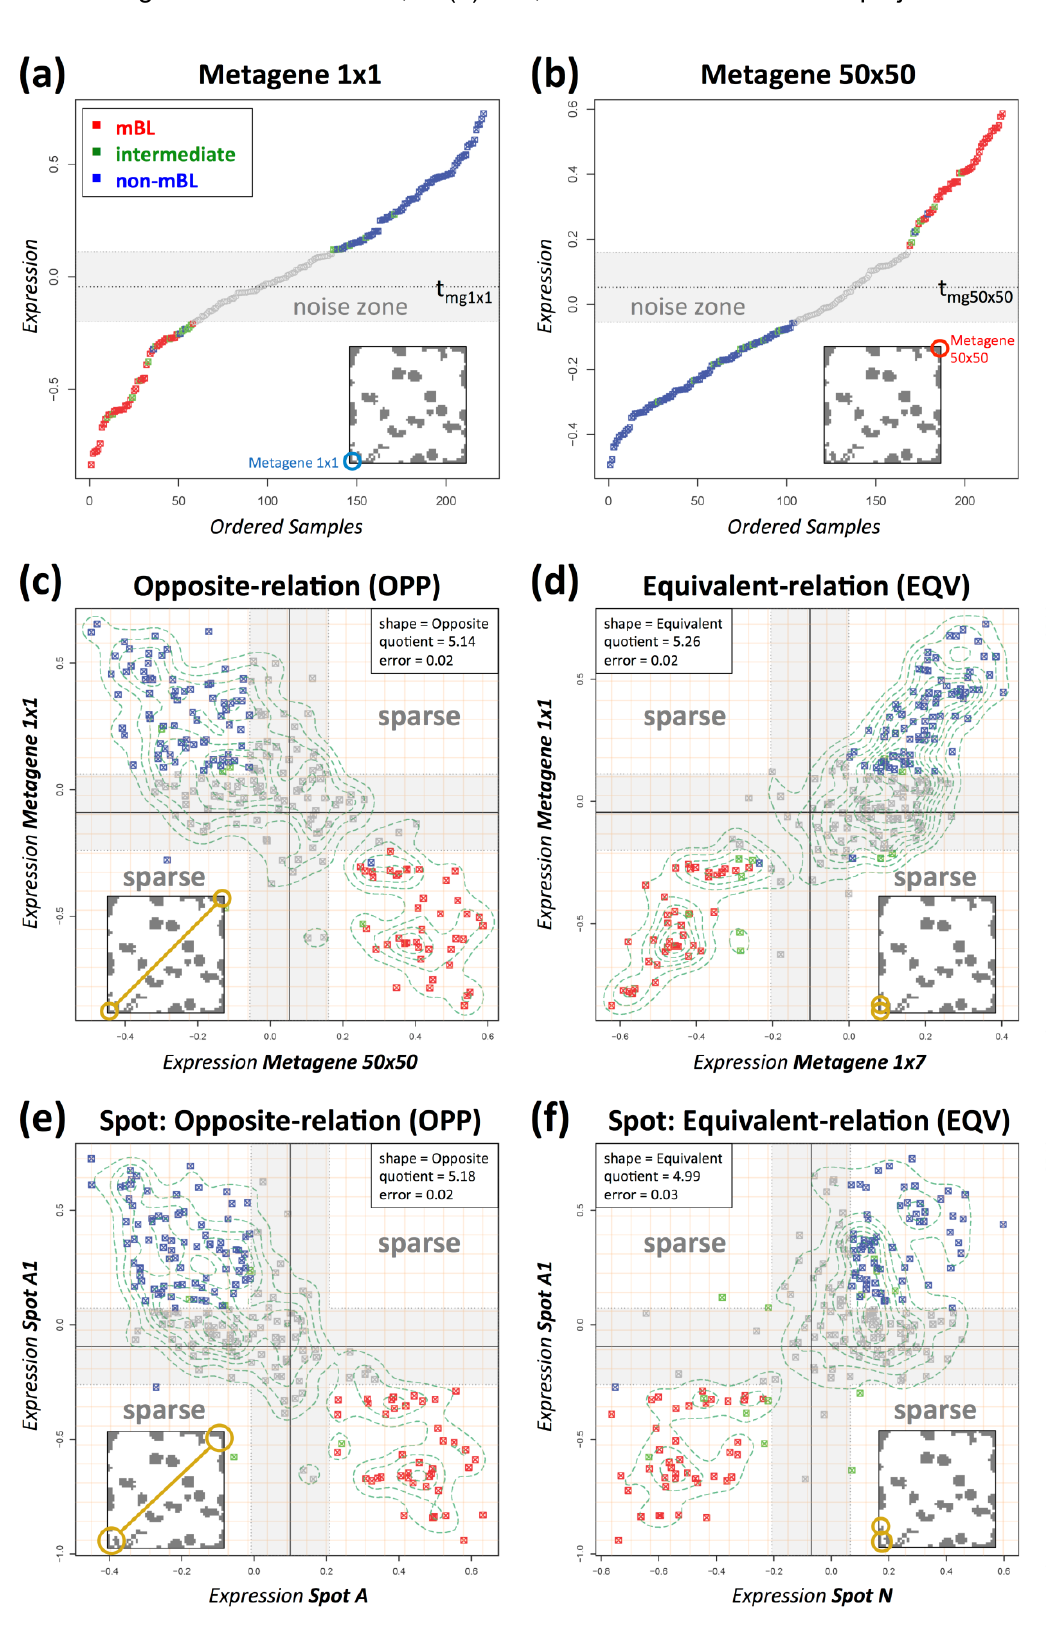
Figure 6: Boolean implication analysis on metagene and spot levels. Ordered expression profiles and scatterplots based on metagene profiles analogous to Figure-5 (panels a-d) and based on spot expression profiles (panels e and f). Positions of the metagenes and spots in the SOM map are shown in the icons in each of the